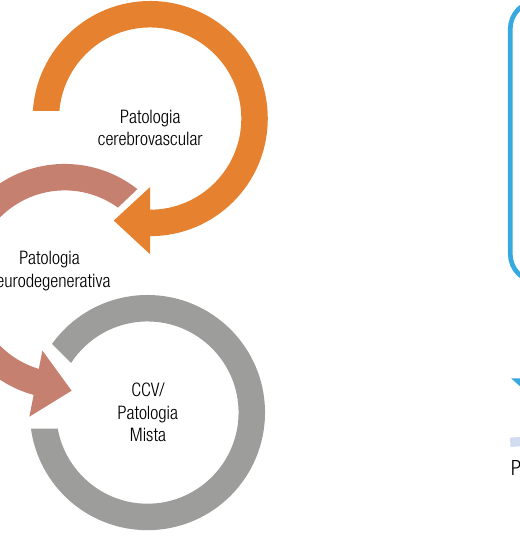
Figura 1 A e B. Relação entre comprometimento cognitivo vascular e demência, adaptado 99 . O CCV se refere a qualquer grau de declínio cognitivo relacionado à patologia cerebrovascular, desde as fases pré-clínicas (cérebro em risco), passando pelo CCLV e demência. O CCV pode ser causa isolada do declínio cognitivo ou, em algum grau, coexistir com patologia neurodegenerativa como a DA. O termo Demência Vascular se refere ao